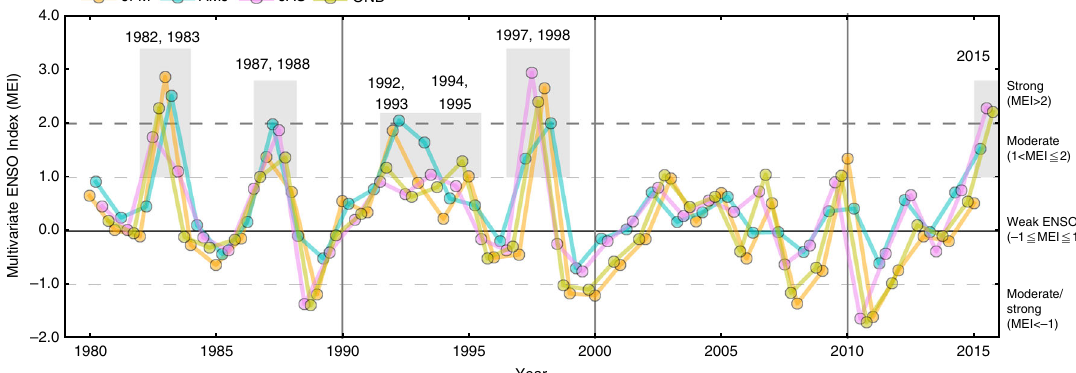
Fig. 3 Interannual variability in seasonal Multivariable El Niño-Southern Oscillation Index. Interannual variability in seasonal (3-month averaged, i.e. JFM, AMJ, JAS and OND) Multivariable ENSO Index (MEI). Boundaries for the El Niño and La Niña categorization are indicated by dashed lines, and years correspond to the condition for the intense El Niño years are highlighted by grey shadings